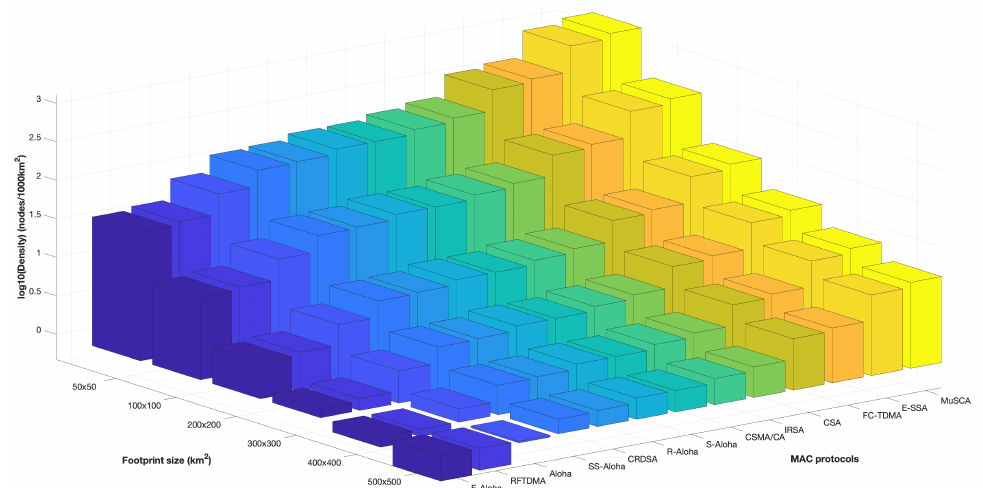
Figure 8. Graphic representation of the density of nodes for each MAC protocol for applications that send 38